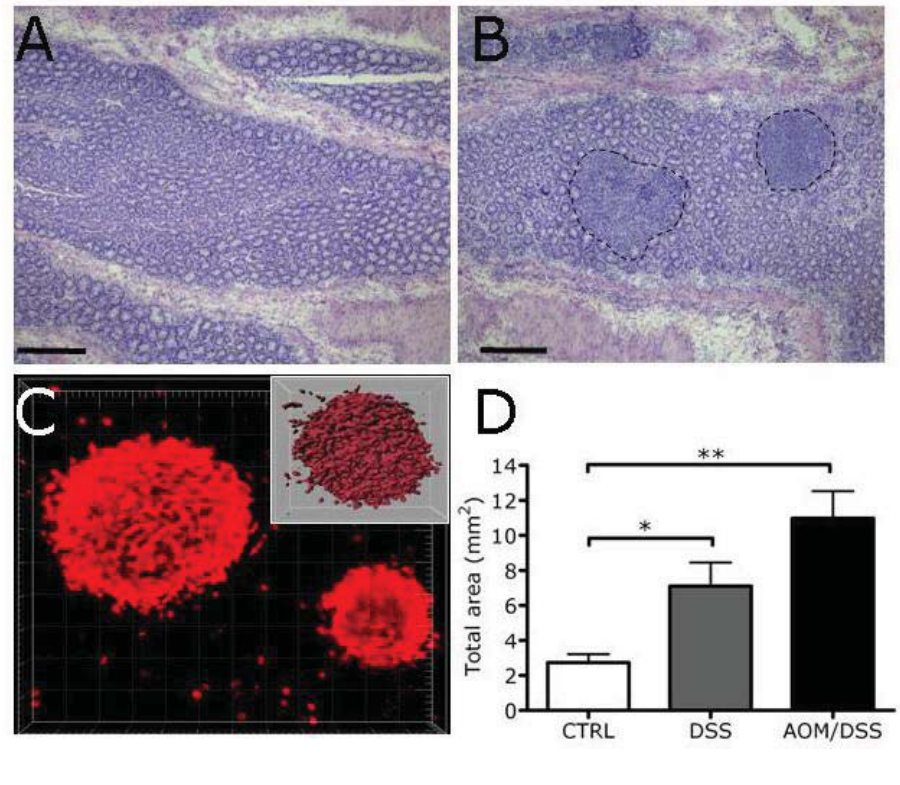
Figure 4. B cell follicles increase in a model of colon carcinogenesis. ( A , B ) Representative H&E of colon mucosa in CTRL mice and after the AOM/DSS treatment. Dot lines show lymphoid aggregates. Scale bar = 100 μ m; ( C ) Morphometric analysis of the lymphoid aggregates by 3D visualization of B220 + follicles (in red) in colon whole mounts. Isosurfaces were obtained by importing confocal RGB image stacks to Imaris software (inset); ( D ) Quantification of volume of the lymphoid aggregates. (n = 3 mice, Ctrl; n = 3 mice DSS; n = 3 mice AOM/DSS; bars represent